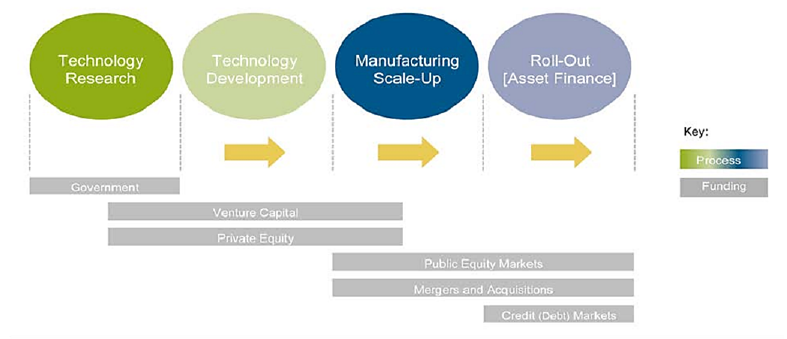
Figure 2. Bloomberg New Energy Finance tracks